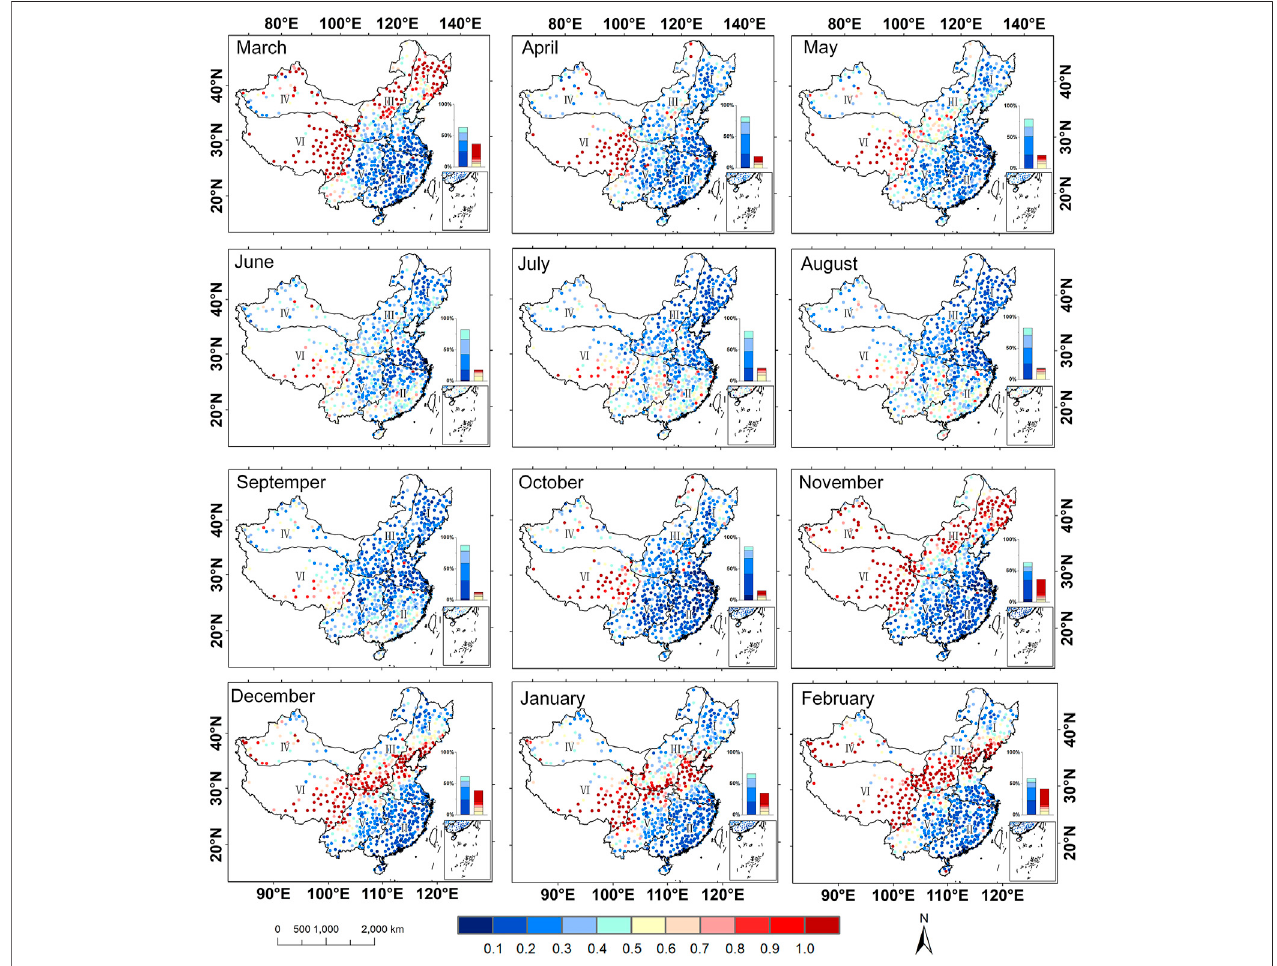
FIGURE 7 | Spatial distribution of DISO for the TNx of ERA5 over China from spring to winter. Spring (March, April, and May), summer (June, July, and August), autumn (September, October, and November), and winter (December, January, and February).